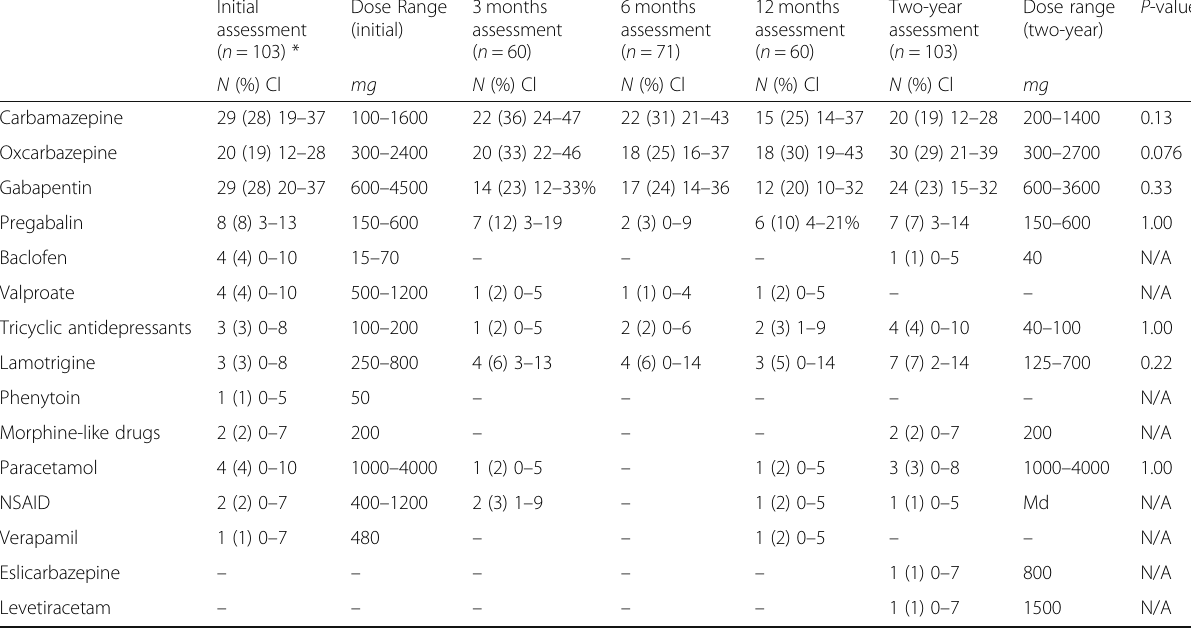
Table 6 Drugs used for trigeminal neuralgia at initial and follow-up assessments Initial